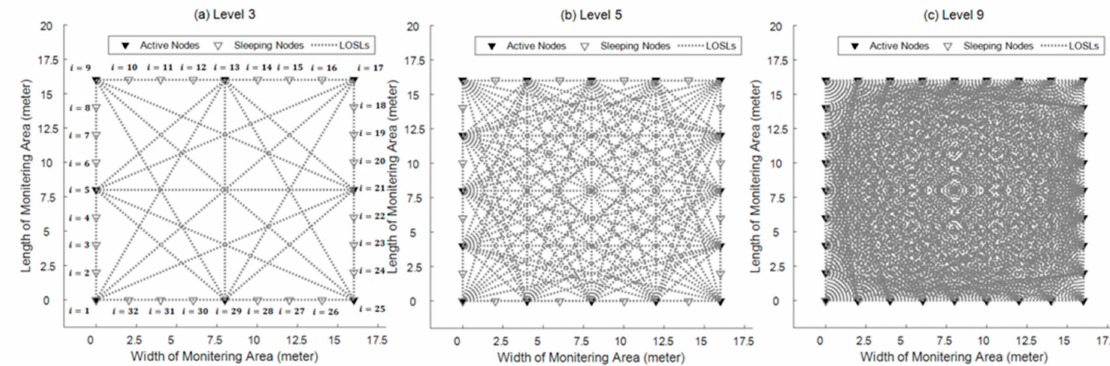
Figure 7. Three topical levels of the proposed adjustable networking scheme (N = 3, 5,